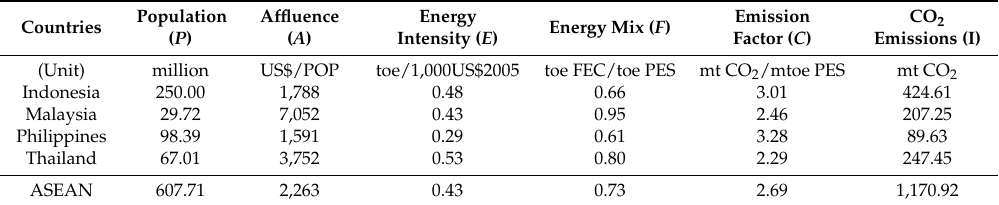
Emission Factor ( C )